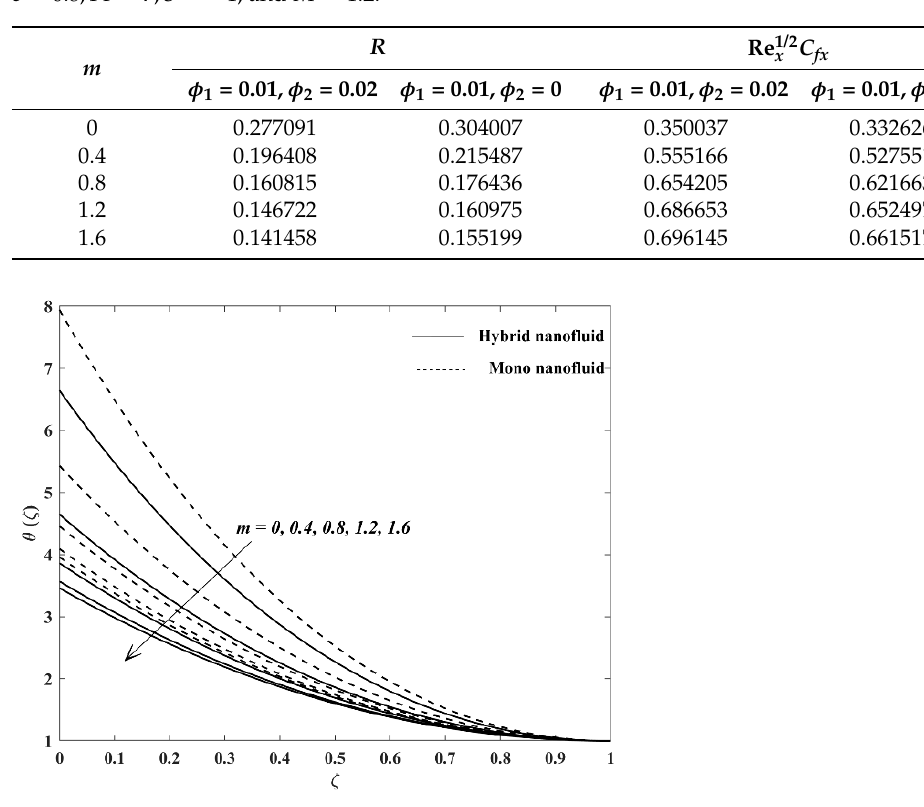
Table 6. As the power-law index m undergoes variation, numerical approximations are made for the values of both the dimensionless film thickness or R , as well as the local skin friction coef- ficient, Re 1/2 x C fx . These approximations are based on specific parameters including We x = 0.05, ε = 0.8,Pr = 7, S = − 1, and M = 1.2.